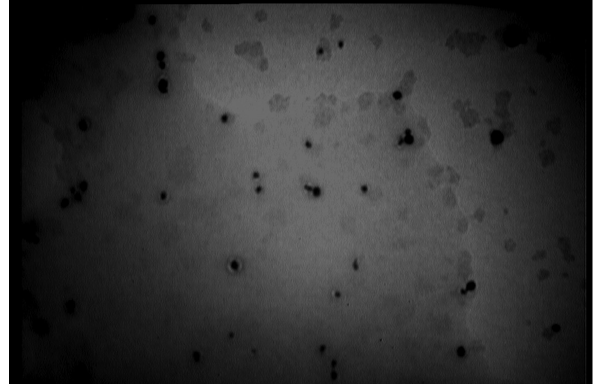
Figure 5 Transmission electron microscopy (TEM) micrograph recorded from a drop-coated film of an aqueous solution of Ag + ions incubated with freshly cultured S. boulardii (after 5 h biotransformation).